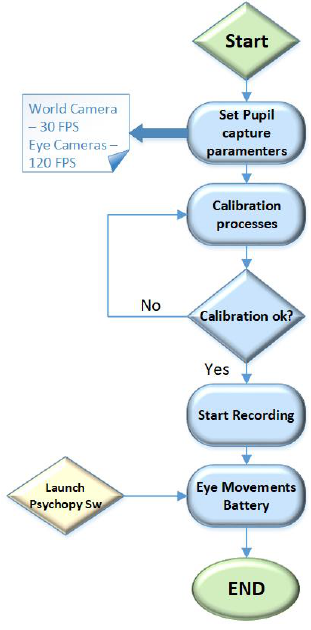
Figure 3. Eye movements test